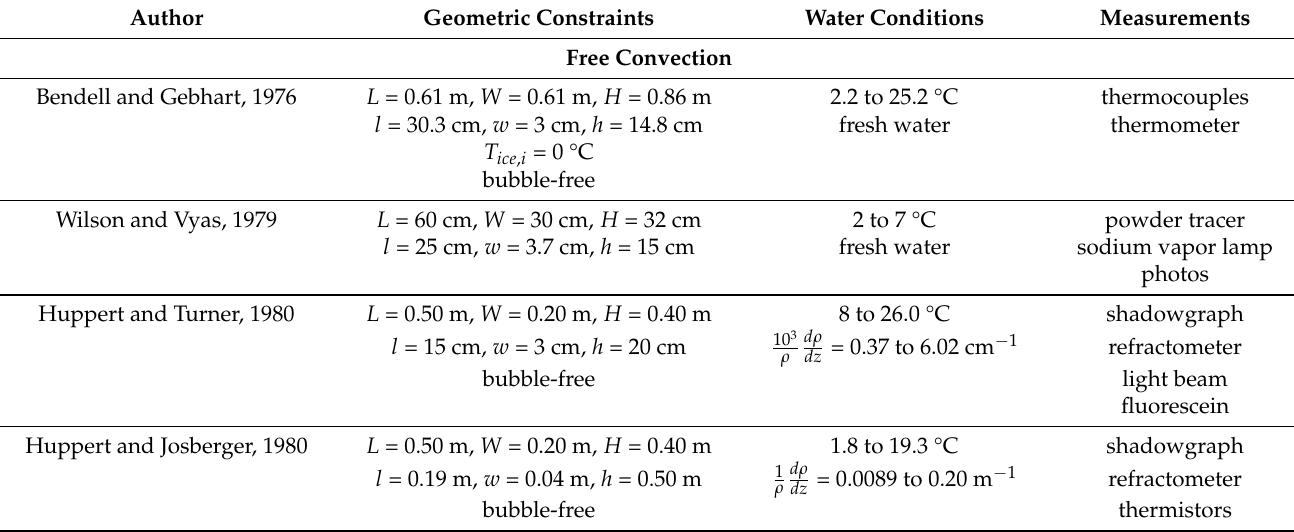
Table A3. Experiments focused on flow patterns and melting at the face of a vertical ice wall in free